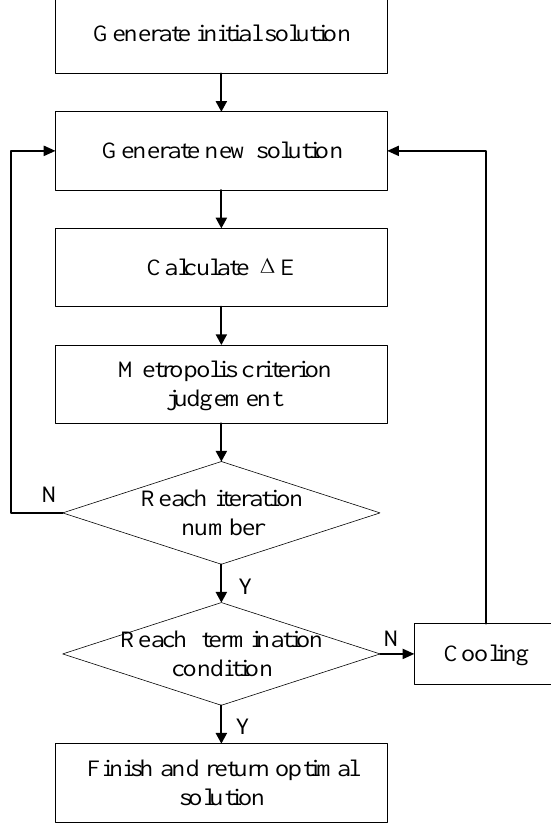
Figure 4. Simulated annealing (SA)